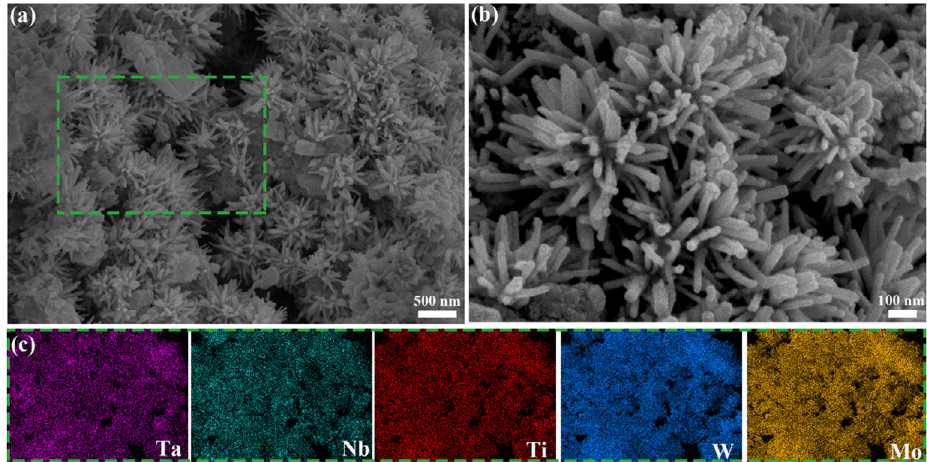
Fig. 3 SEM characterizations of the as-synthesized HEB-1 products: (a) low-magnification SEM image; (b) high-magnification SEM image; (c) EDS elemental